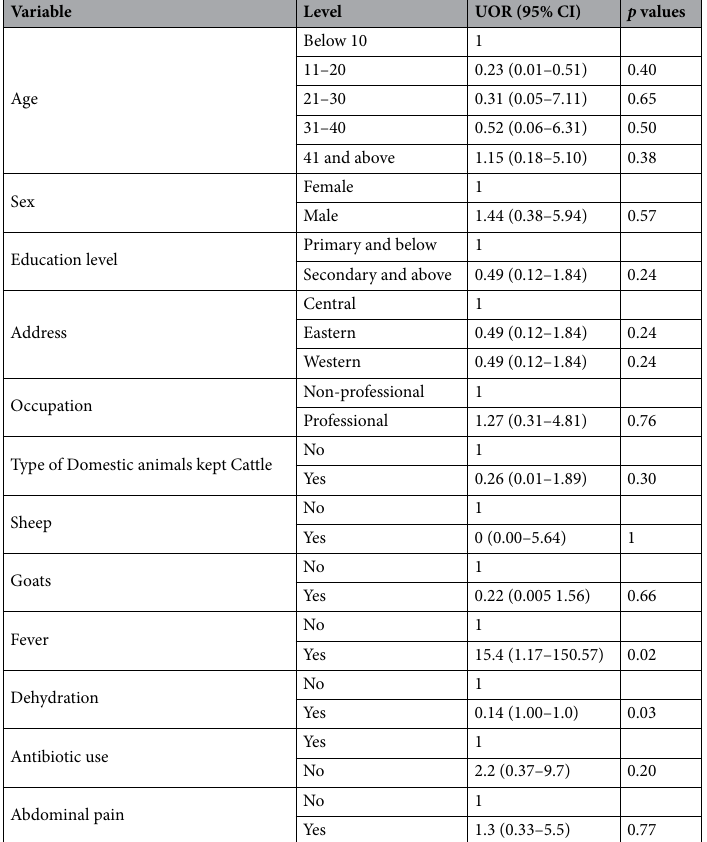
Table 3. Bivariable analysis-table. Where CI = confidence interval, UOR = unadjusted odds ratio, % = percentage, AOR = adjusted odds